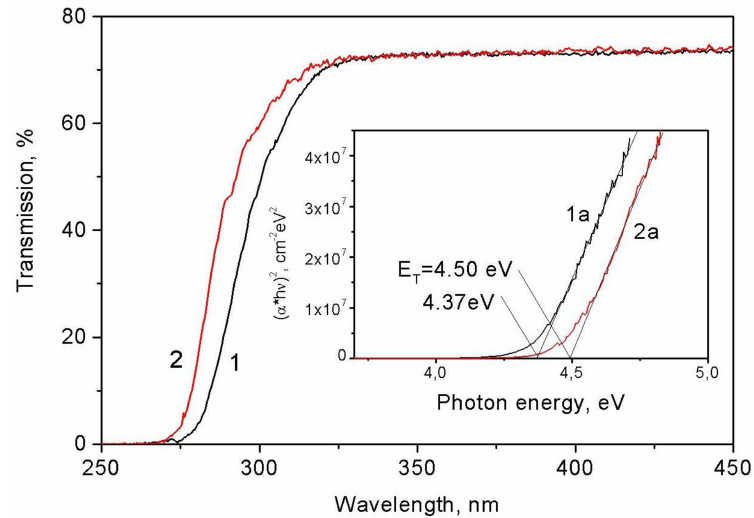
Figure 9. The short-wave edge of the rippite transmission spectra at 300 (curve 1) and 80 K (curve 2). In the insert: the Tauc plot for the case when the edge shape is determined by direct allowed electronic transitions. The band gap E g for rippite is 4.37 and 4.50 eV at 300 and 80 K,